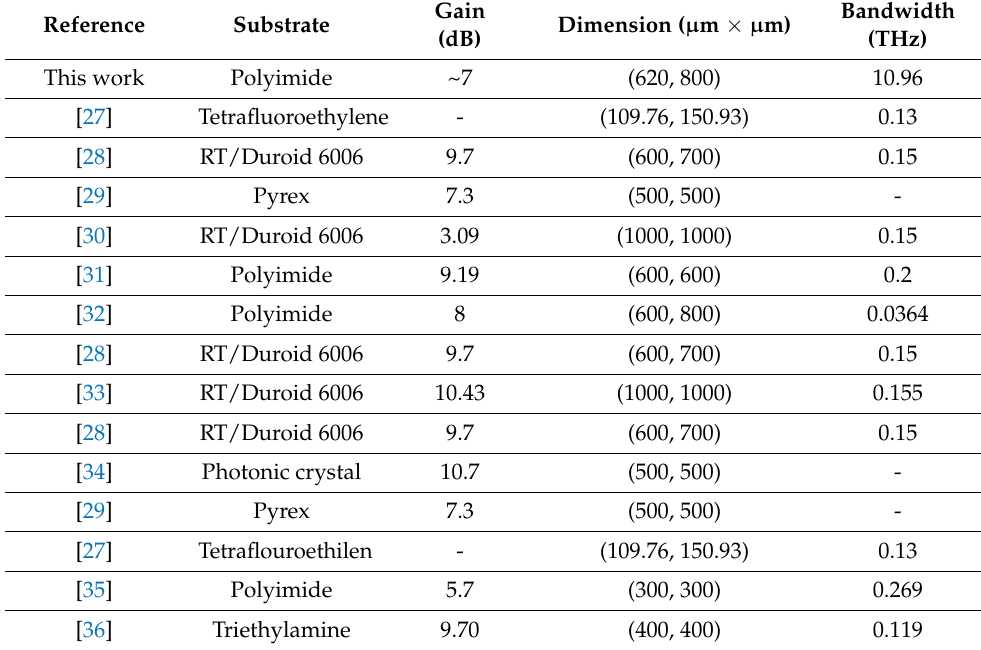
Table 3. Comparative analysis of the proposed structure with previously published